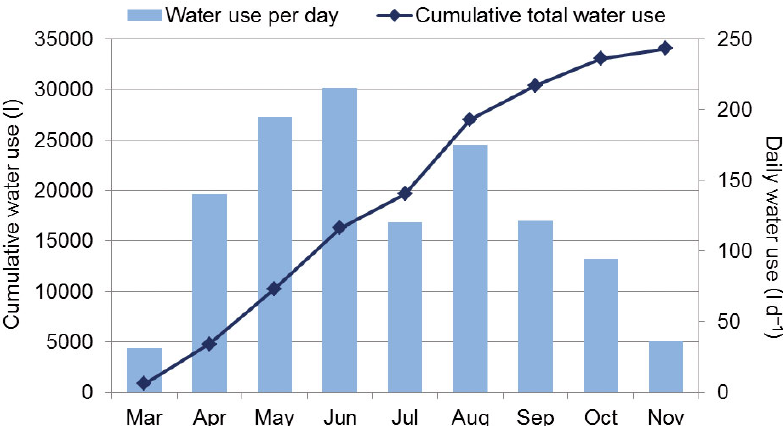
Fig. 6. Use of fish water by tomato plants Solanum lycopersicum during the whole testing